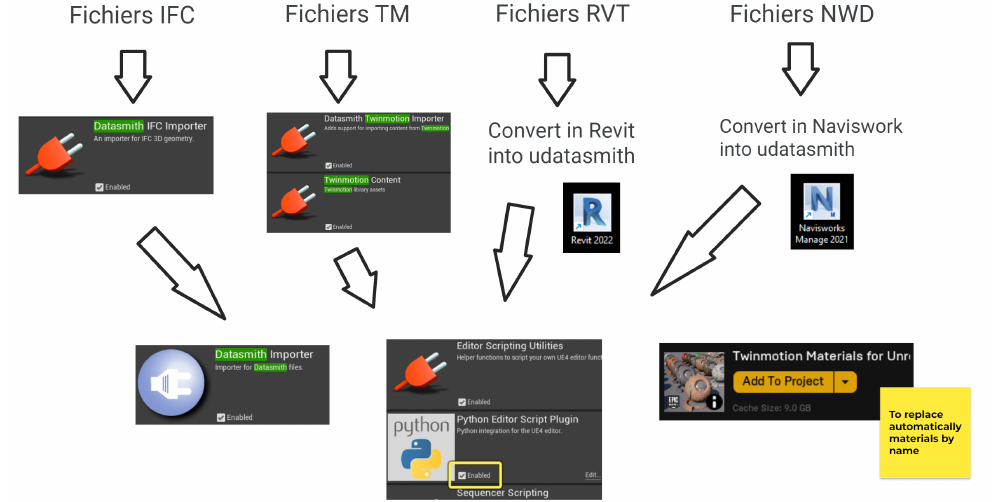
Figure 12. Examples of workflow with the Datasmith exporter